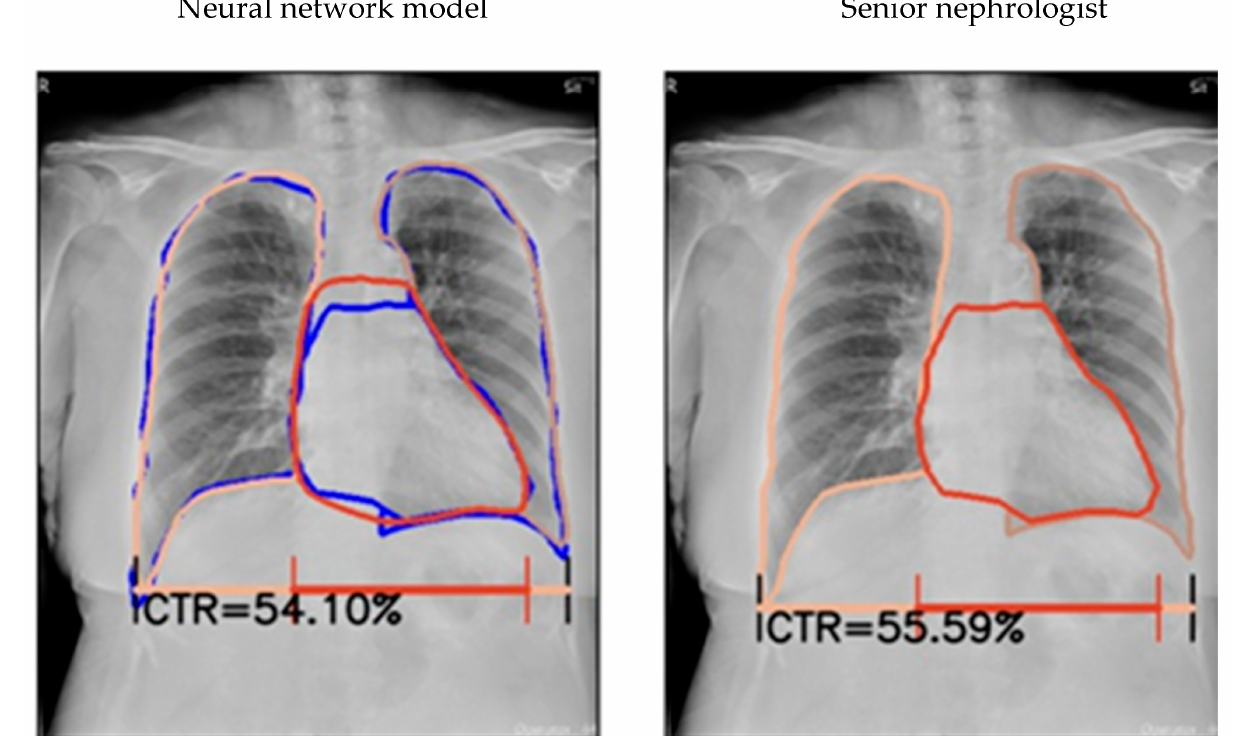
Figure 1. Illustration of the segmentation of the heart and lungs margin by manual annotation and the neural network model. The blue line was predicted by the neural network model, and the red and orange lines are the cardiac and lung margins, respectively, annotated by a senior nephrologist.